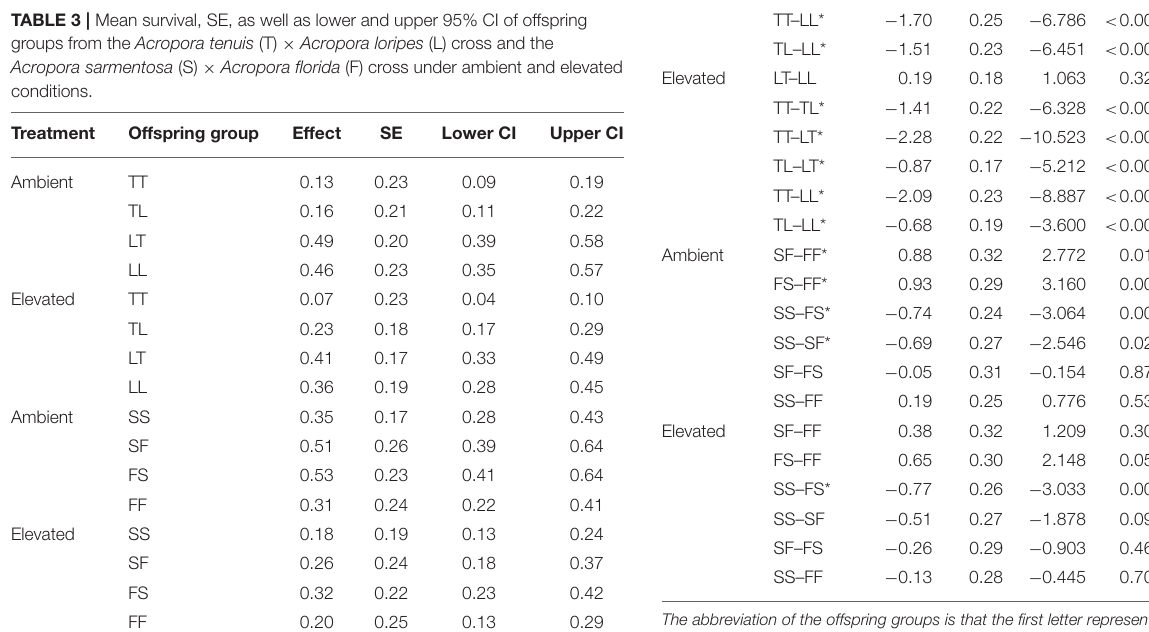
TABLE 3 | Mean survival, SE, as well as lower and upper 95% CI of offspring groups from the Acropora tenuis (T) × Acropora loripes (L) cross and the